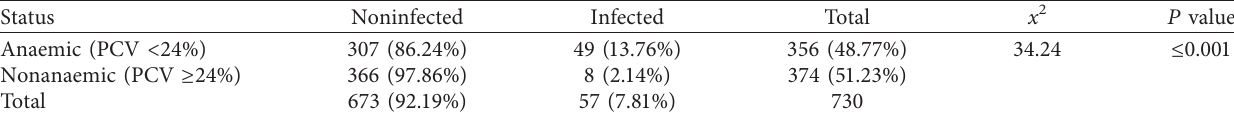
Table 3: Association of trypanosomes infection and the occurrence of anaemia.